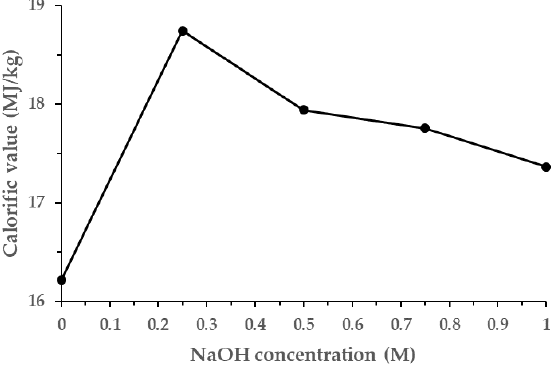
Figure 1. Variations on the calorific values of pretreated RH samples.